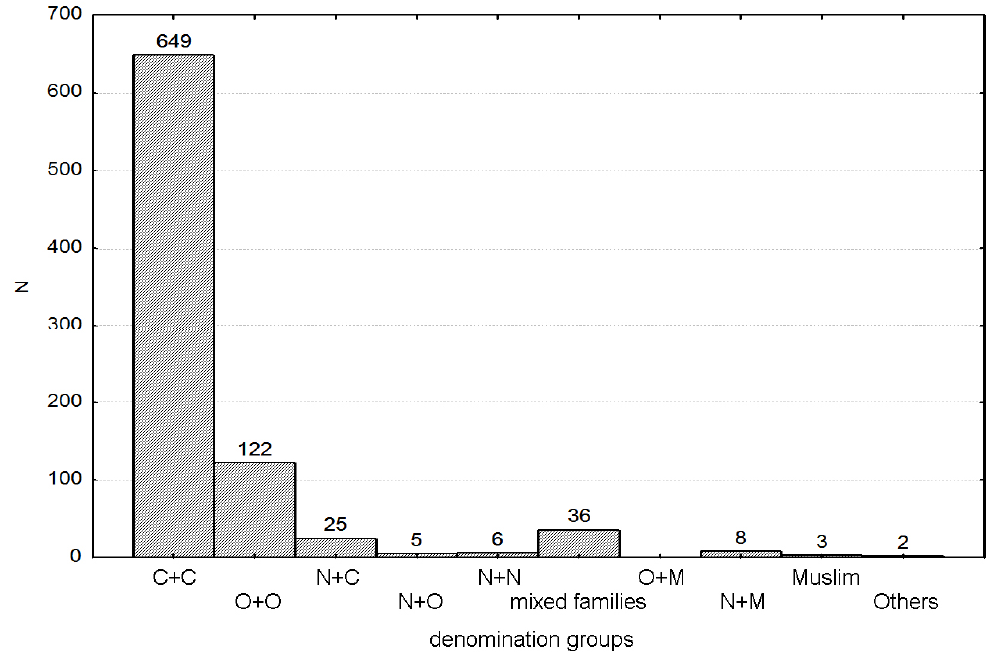
Figure 11. Denomination of respondents and their families. Source: own study based on research